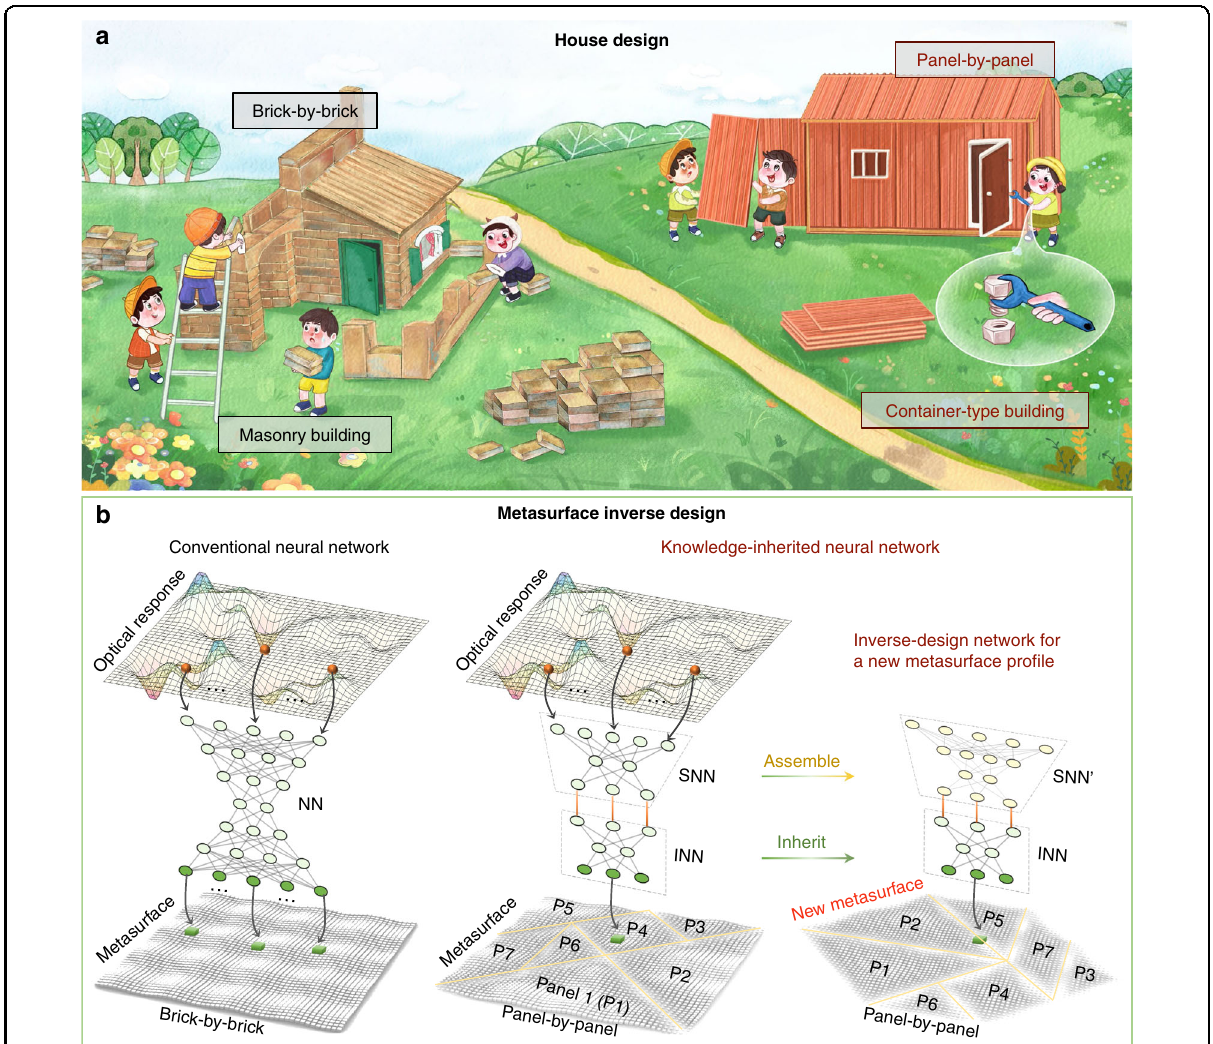
Fig. 1 Schematic of the knowledge-inherited neural network for metasurface inverse design. a House building. In masonry buildings, all bricks are stacked and fi xed with mortar, while container-type buildings are built with detachable “ panel-by-panel ” assemblies. b Knowledge-inherited paradigm for a metasurface inverse design. Similar to “ brick-by-brick ” masonry buildings, conventional neural networks are inseparable, fossilized, and single-functional once built up. In contrast, the proposed knowledge-inherited neural network is oriented for multi-object and shape-unbound metasurfaces. It is composed of two functional networks, the INN and the SNN. For a given “ offspring ” metasurface, we can synthesize the